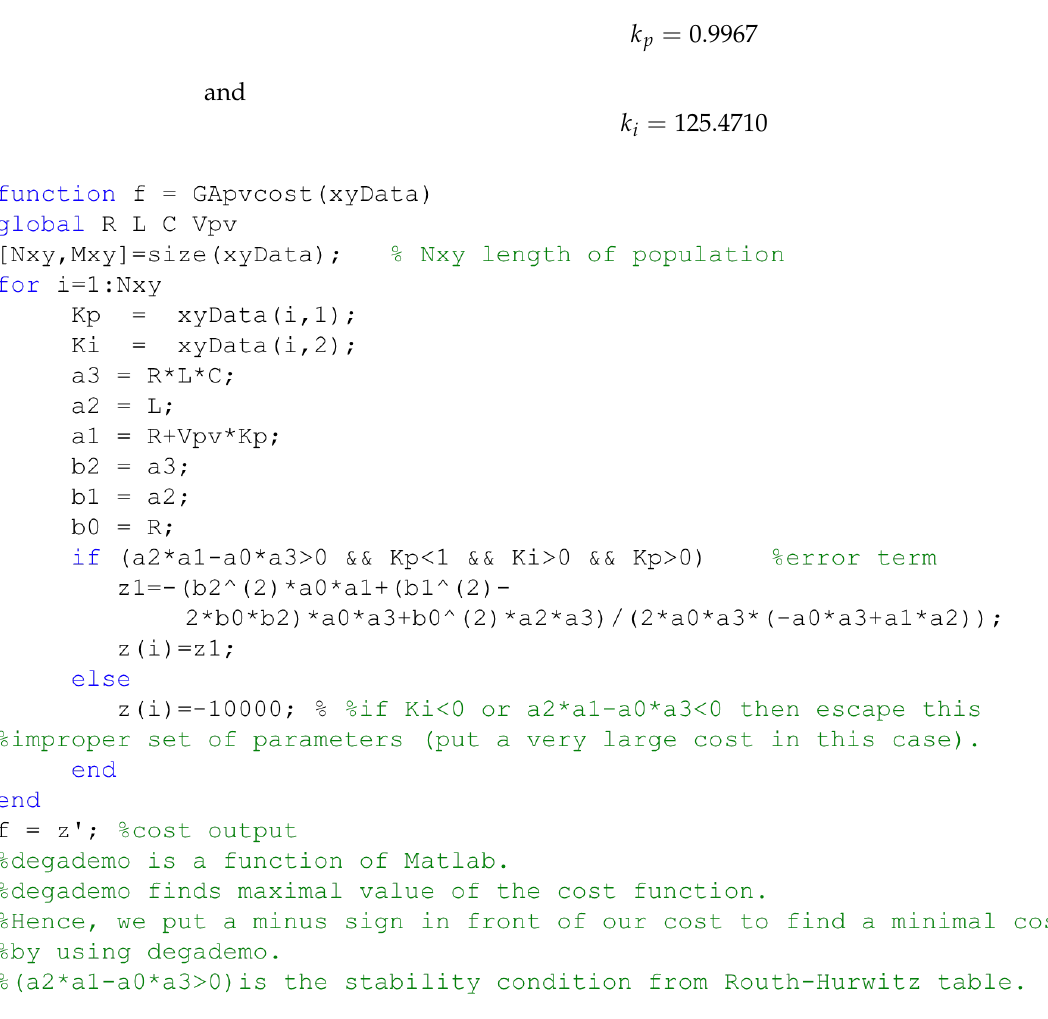
Table 1. The Routh’s tabulation.